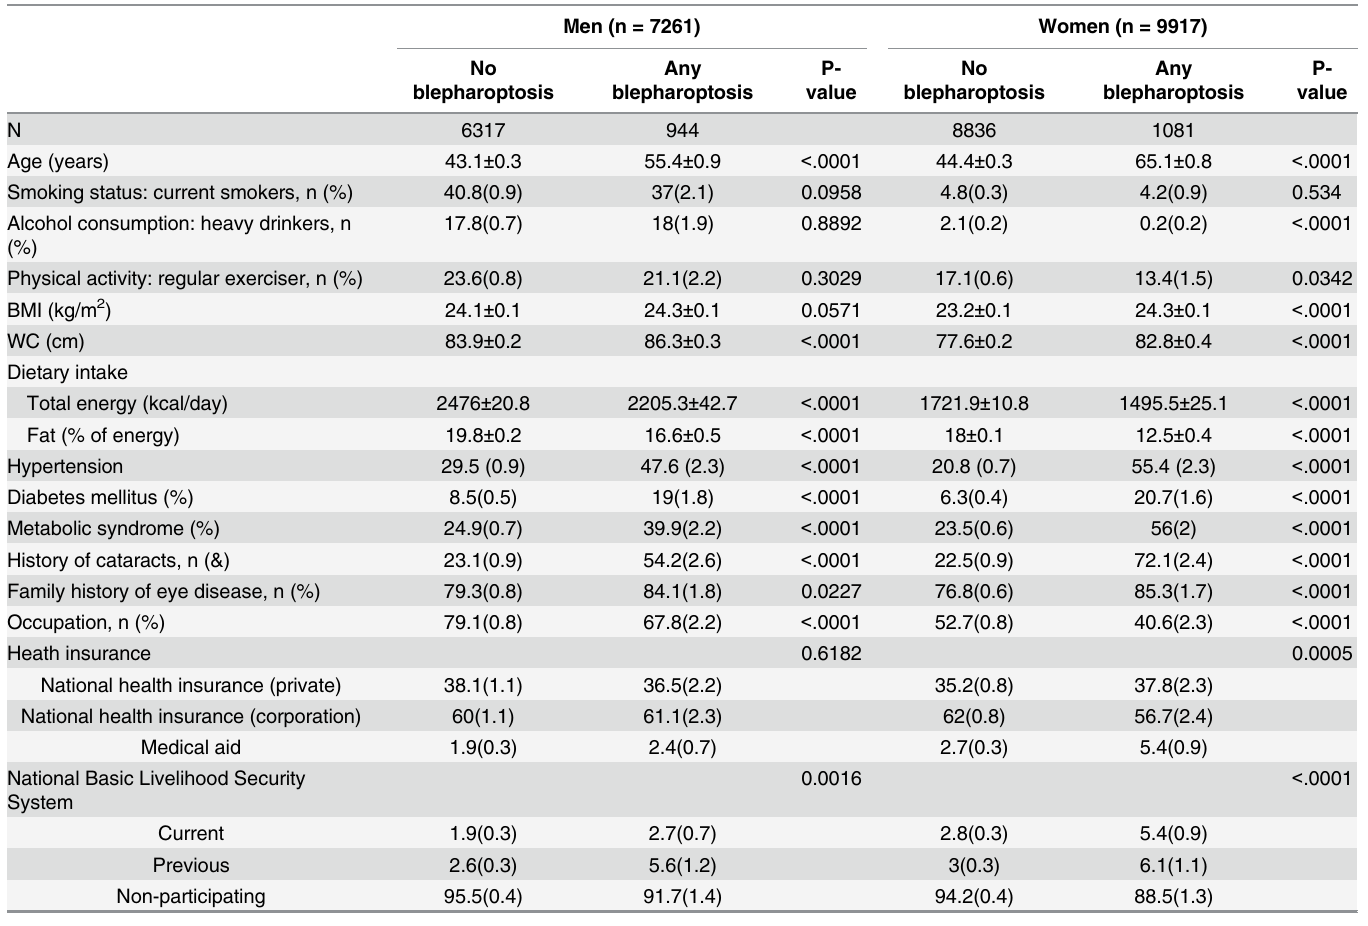
Table 1. General characteristics of study subjects according to the